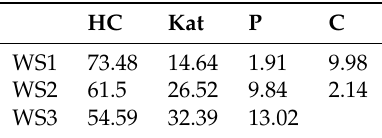
Table 6. Rietveld refinement of the water-to-solids ratio series of LDHs WS1 = 70:30, WS2 = 80:20 and WS3 = 90:10. HC indicates the phase [Ca 4 Al 2 (OH) 12 ][(CO 3 ) · 5H 2 O], Kat is katoite, P is portlandite and C is calcite. All values are given in percentages of the crystalline phases.